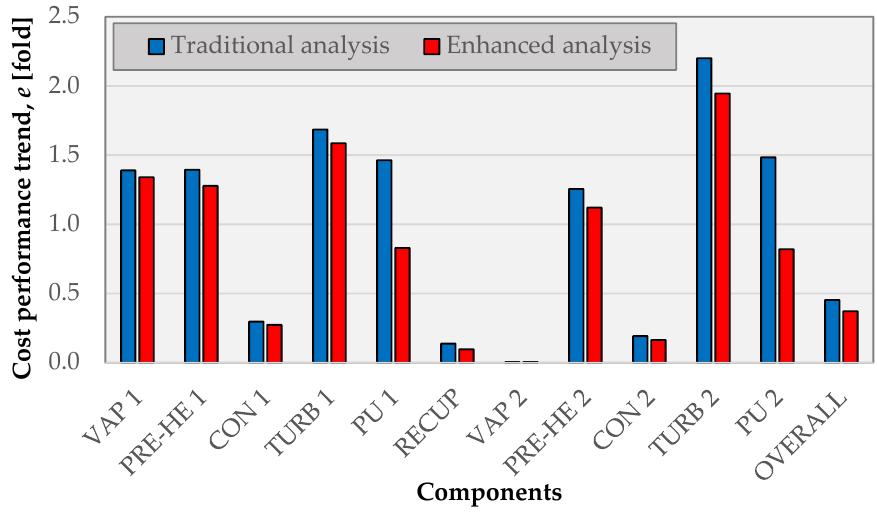
Figure 5. Change in cost performance trend for the components for both analyses.